Question: Condense the content of this figure into a single sentence.
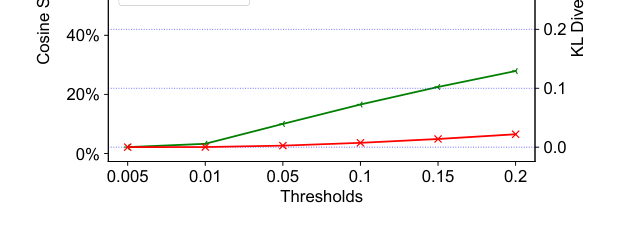
Answer: Information leakage with different thresholds. Co- sine similarity and KL divergence between two latent-space images are used to test the effect of information preserv- ing. With the increase of threshold, the similarity between the encrypted image and the original image will decrease, while the plain image becomes more similar with the origi- nal one. Considering that the behavior of similarity keeps stable in each iteration, the last iteration is chosen for the experiments.